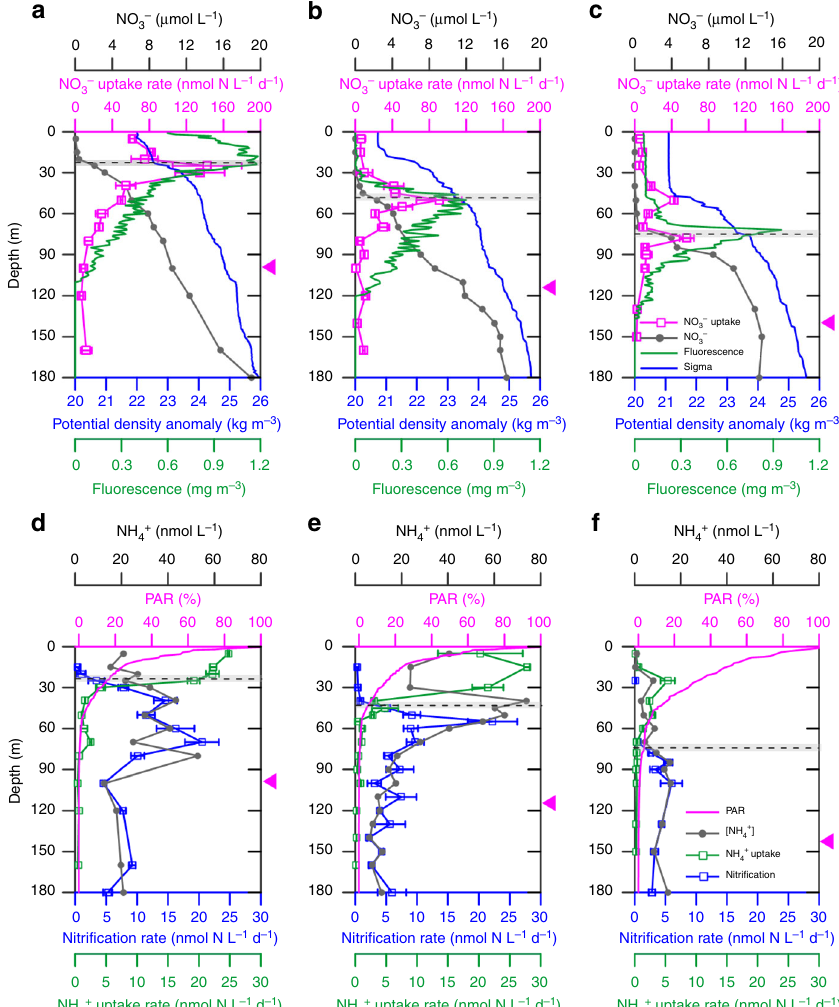
Fig. 1 Depth pro fi les of physical-chemical parameters and NH 4 + consumption rates in the South China Sea in the summertime of 2014. a , d Station D1; b , e Station H3; c , f Station X2. Panels a − c show NO 3 − concentrations (gray solid dots); NO 3 − uptake rates (pink open squares); potential density anomalies (blue line) and chlorophyll fl uorescence values (green line). Panels d − f show NH 4 + concentrations (gray solid dots); percent of surface PAR (pink curve); NH 4 + uptake rates (green open squares), and nitri fi cation rates (blue open squares). Gray bars mark the depth range with the steepest NO 3 − gradient and the black dashed lines within them show the nitracline depth; pink triangles on the right Y -axis mark the euphotic zone depth (0.1% of surface PAR). Error bars of NH 4 + uptake rates, NH 4 + oxidation rates, and NO 3 − uptake rates are represented by the standard deviation of duplicates, and are smaller than the symbols where not